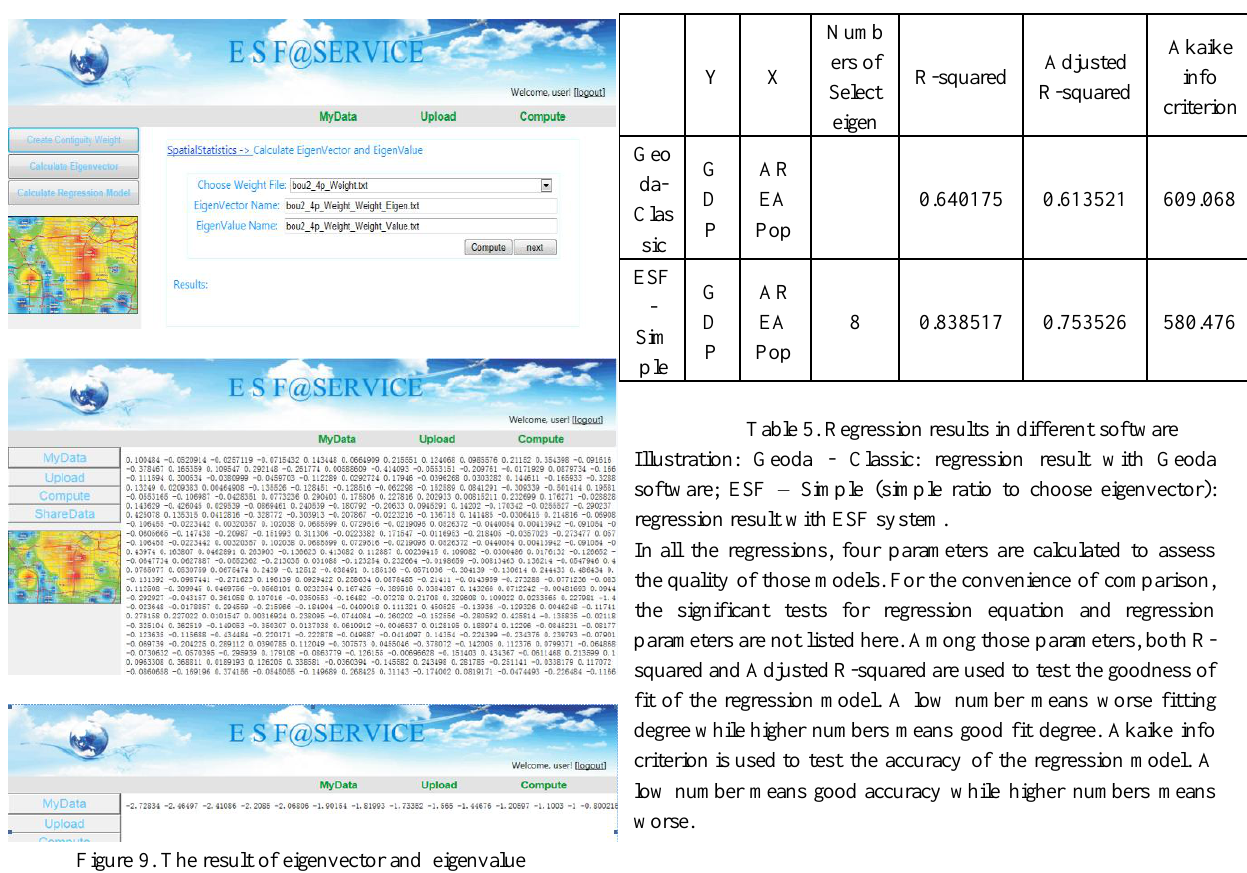
Figure 9. The result of eigenvector and eigenvalue